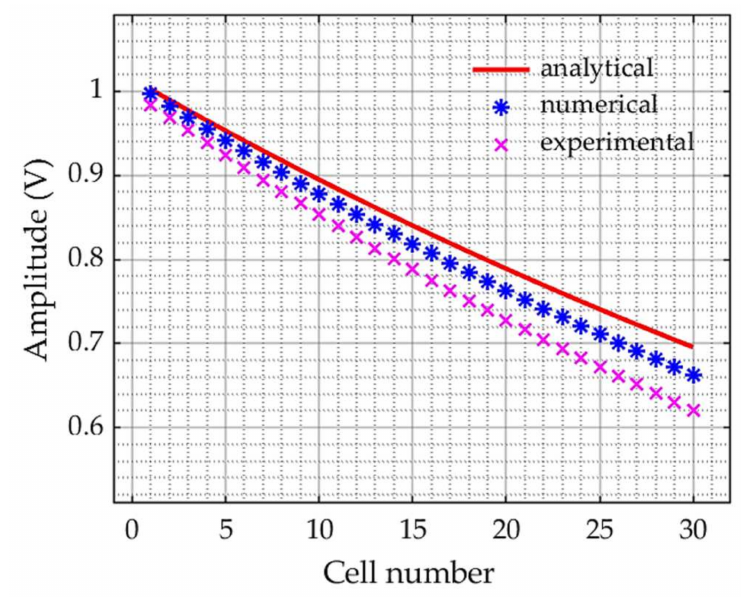
Figure 7. Effect of losses present in NLTL on the bright soliton